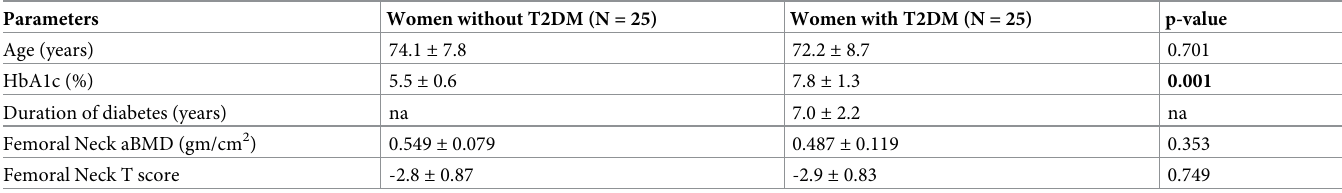
Table 1. Baseline demographic and radiographic parameters of women with and without T2DM included in the present study.